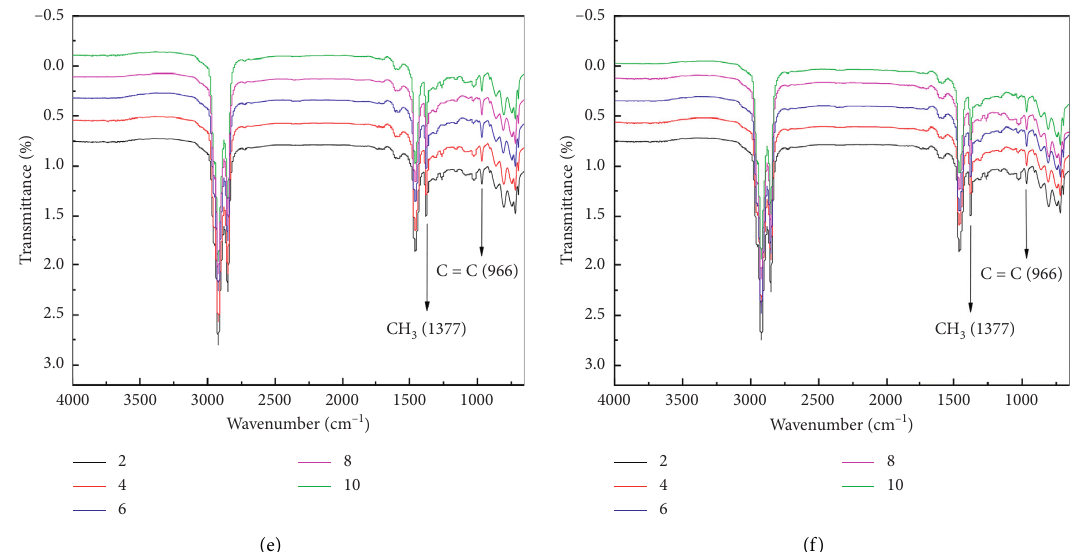
Figure 12: Infrared spectrum of three modified asphalts with different storage days. (a) The result of SBSMA at the top. (b) The result of SBSMA at the bottom. (c) The result of SBS+CNTs-I at the top. (d) The result of SBS+CNTs-I at the bottom. (e) The result of SBS +CNTs-II at the top. (f) The result of SBS+ CNTs-II at the bottom.